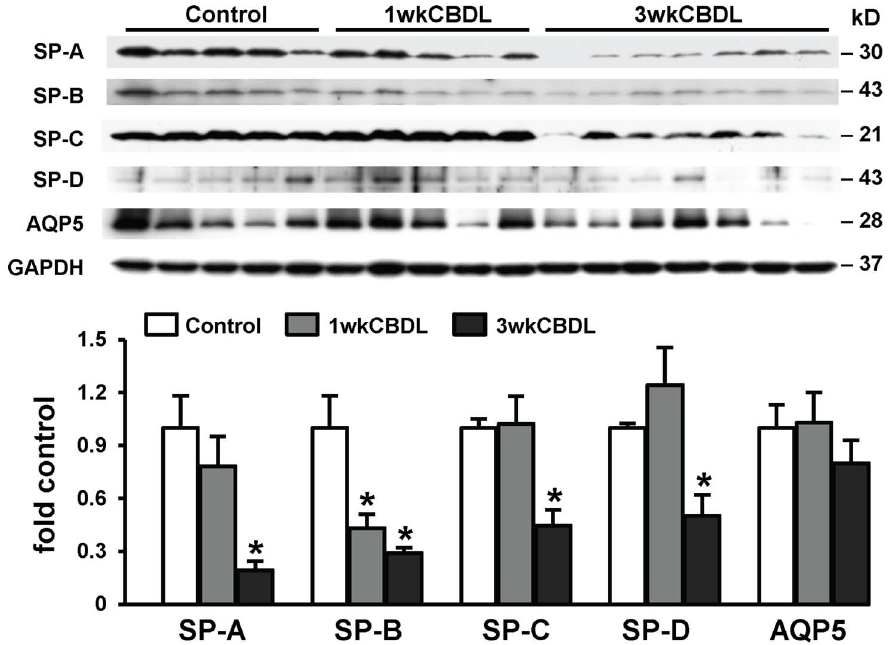
Figure 1. Pulmonary surfactant associated protein (SP) levels after CBDL. Lung tissues were obtained from common bile duct ligation (CBDL) animals at 1 and 3 weeks after ligation. The protein levels of SPs and aquaporin 5 (AQP5, an alveolar type I epithelial cell marker) in lung homogenates were assessed by western blots. Three independent experiments were performed. Top panel, representative immunoblots of SP-A, SP-B (precursor), SP-C (precursor), SP-D, AQP5 and GAPDH in animal lung. Bottom panel, the graphical summaries of protein levels for SP-A, SP-B, SP-C, SP-D and AQP5. SPs protein levels were normalized to the levels of GAPDH. SPs production was significantly decreased between 1 and 3 weeks after CBDL, whereas AQP5 protein levels remained unchanged. Values are expressed as means ¡ SME. * P , 0.05 compared with